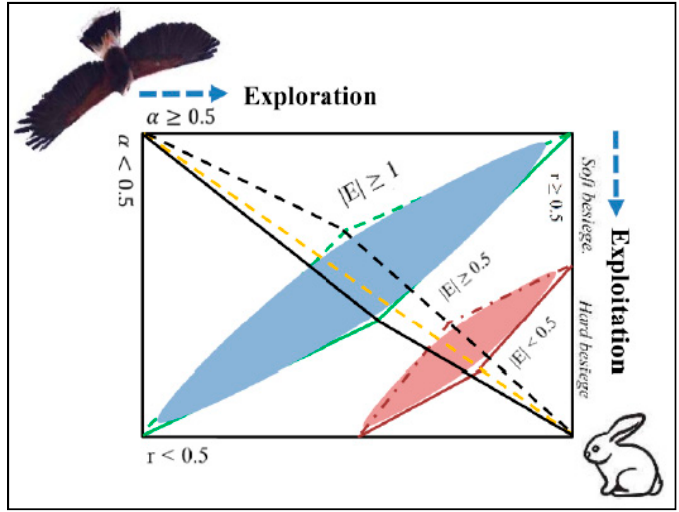
Figure 11. The stages of the HHO algorithm [33].